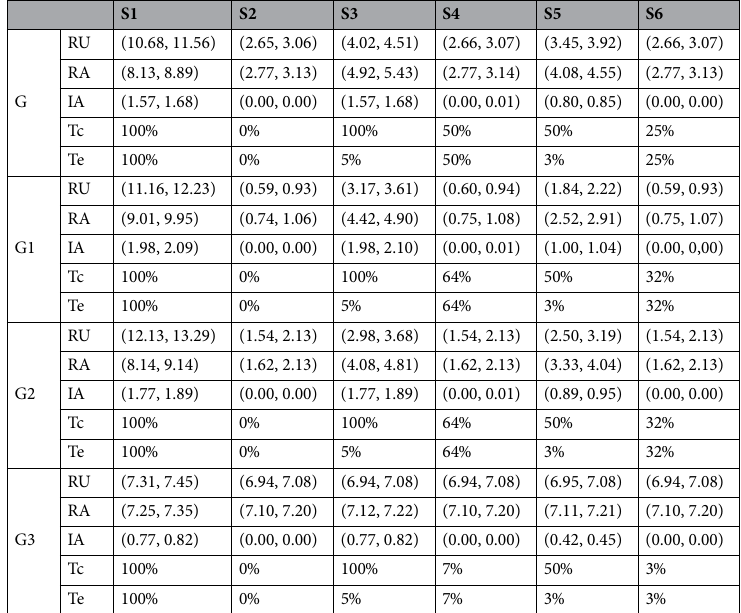
Table 2. Results for effectiveness of travel policy coordination in scenarios S1 through S6 for synthetic data. Shown are 2.5th and 97.5th percentiles of travel effects and health outcomes for scenarios S1 through S6 using estimated epidemiological parameters to simulate epidemic and travel data. G denotes all countries. See Table 1 caption for more information.